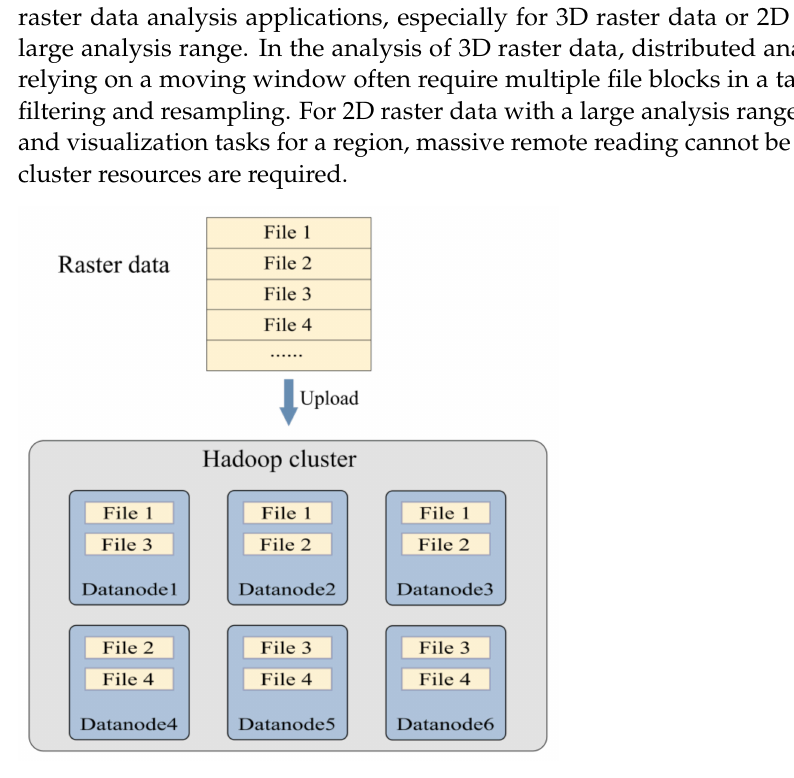
Figure 1. Possible raster data distribution on Hadoop cluster. The raster data are decomposed into rows for